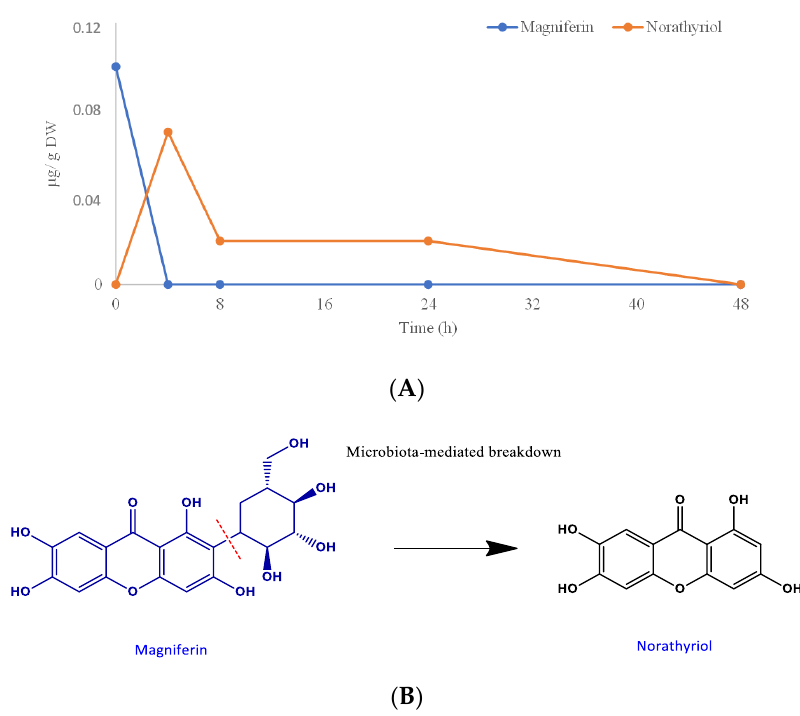
Figure 3. ( A ) Mangiferin degradation profiles over 48 h of incubation with human faeces. Data expressed as µ mol ± SD( n = 3). ( B